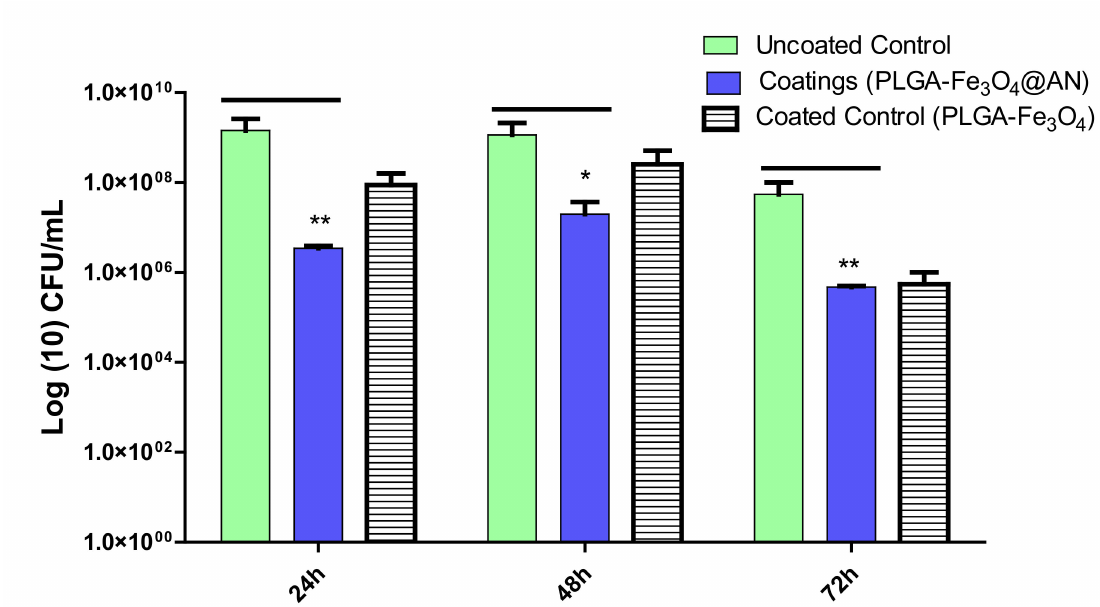
Figure 8. E. coli biofilm formation (expressed as CFU (colony-forming units) / mL values) on control and coated surfaces for 24, 48, and 72 h of incubation at 37 ◦ C (* p ≤ 0.05, ** p ≤ 0.01; comparison of coating vs. control sample for the same time